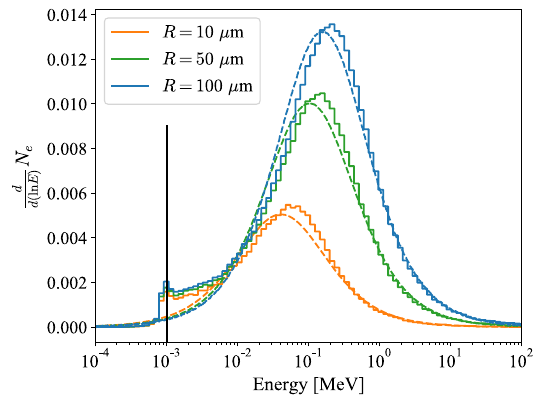
FIG. 5. Energy spectrum of knock-on electrons as they escape the UFO. The updated model (dashed lines) is compared to FLUKA (solid lines) for three dust particle radii. The energy cut for electron transport in FLUKA is shown by the black line, at 1